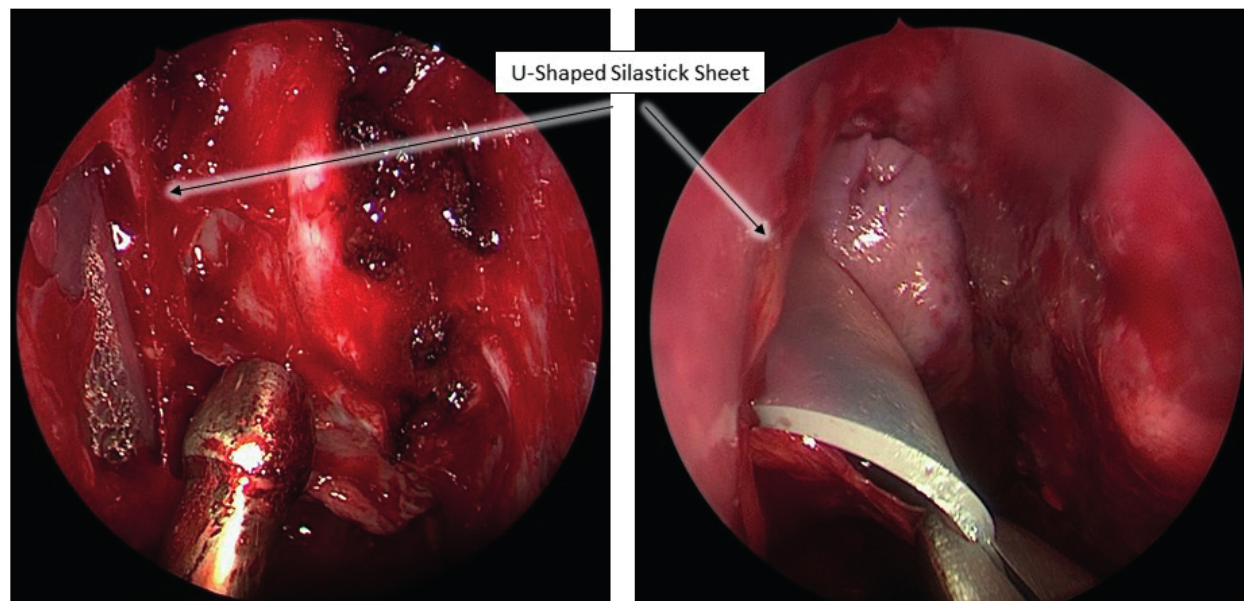
Figure 5. Sizing and placement of the protective Silastic® sheet (cadaveric dissection).